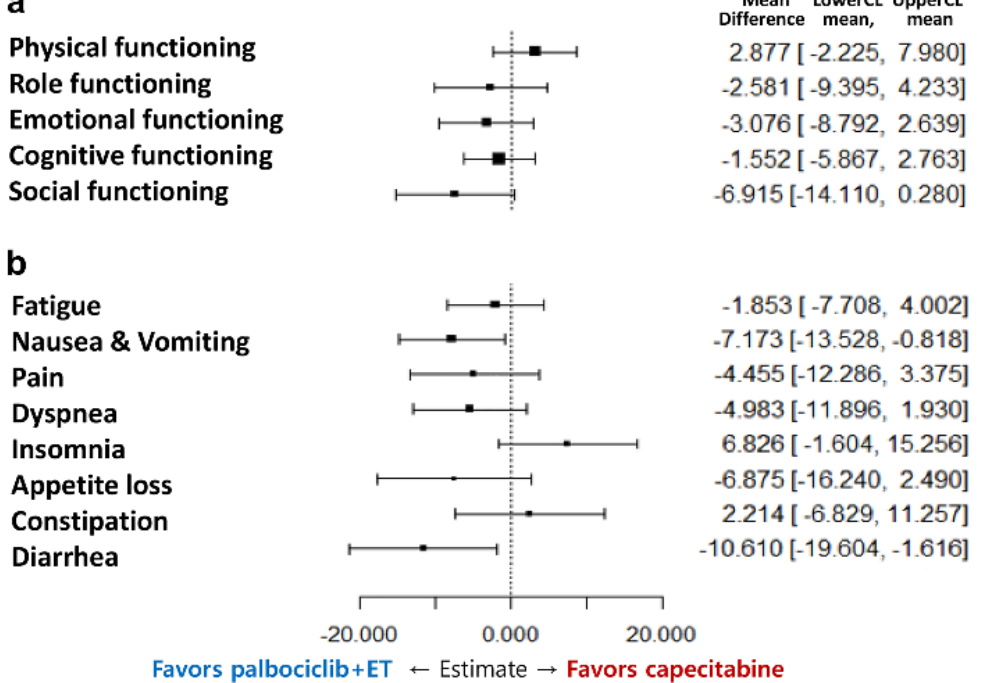
Figure 3. Forest plot model of estimated difference (palbociclib plus exemestane with GnRH agonist and capecitabine) in overall change from baseline in EORTC QLQ-C30. (Repeated-measure mixed-effect model) ( a ) functional and ( b ) symptom scales.